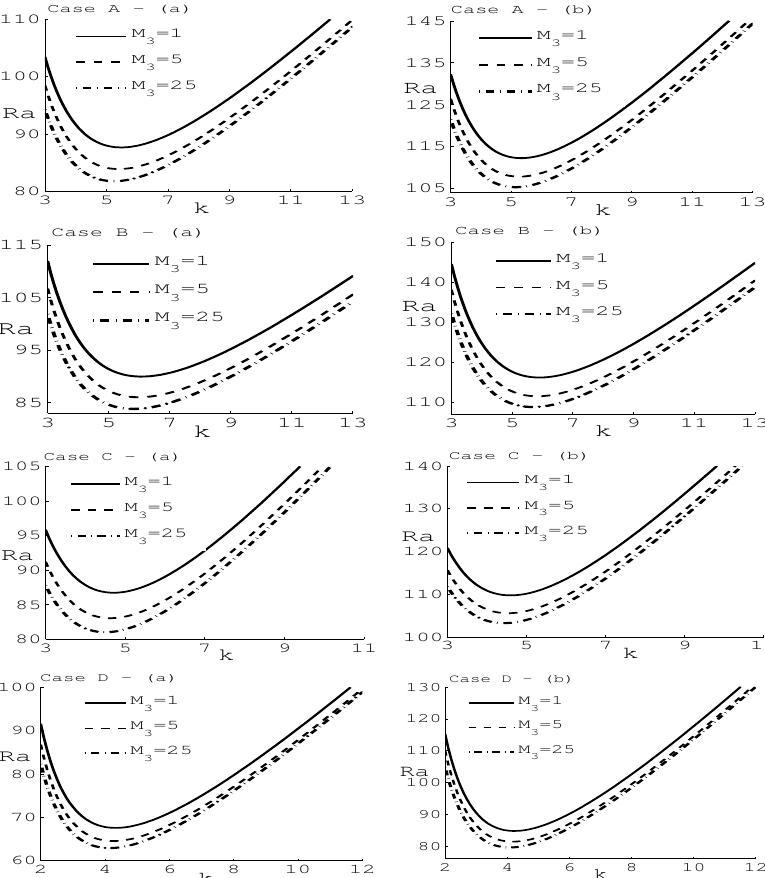
Figure 5. Neutral curves for different values of the nonlinearity of magnetization parameter M 3 for ( a ) water-based ferrofluid and ( b ) ester-based ferrofluid for Case A to Case D. The fixed parameter values are α L = 2, (cid:101) = 0.35, K = 2.0 × 10 − 7 , and d = 0.001